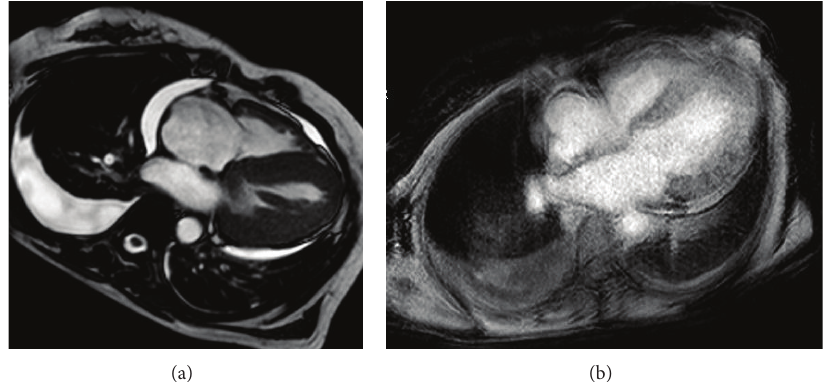
Figure 1: (a) Cardiac MRI shows diffuse infiltration with endomyocardial fibrosis including interatrial septum. Pericardial and pleural effusions demonstrate heart failure. (b) Diffuse and global pattern of late gadolinium enhancement that matches the distribution of amyloid on histology (also exits enhancement at interauricular